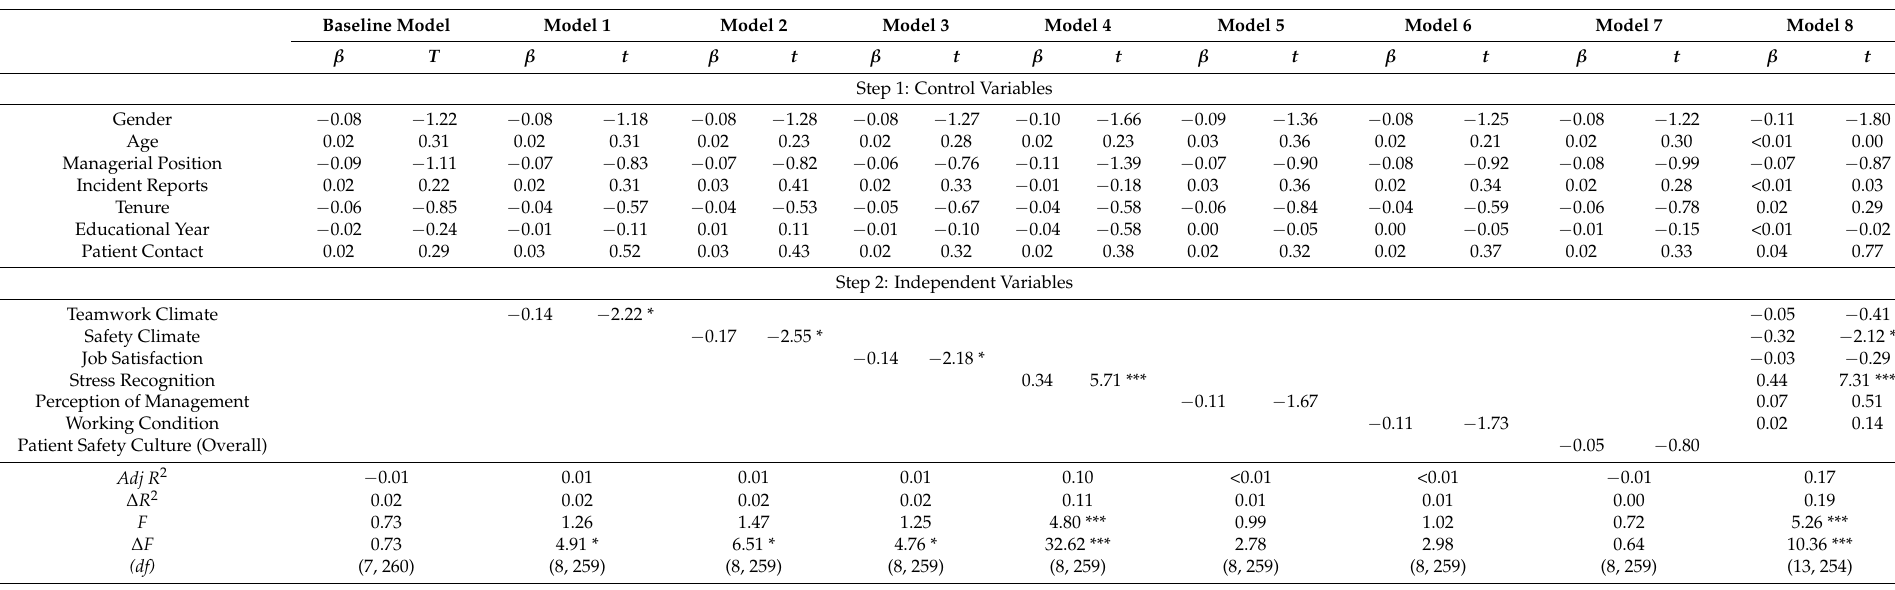
Table 9. Hierarchical regression of patient safety culture on exhaustion ( n =